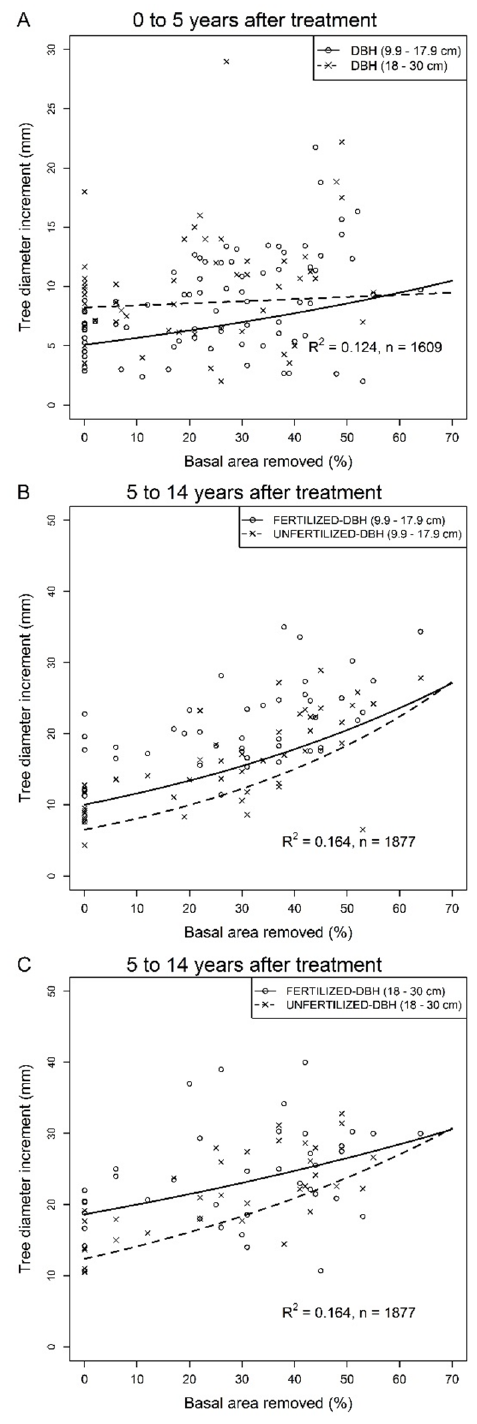
Figure 2. Residual tree response to commercial thinning and fertilization of jack pine stands over periods of 5 and 5 to 14 years following thinning. Fertilization was conducted within sub-plots in each experimental units 3 to 5 years after thinning; ( A ) Tree diameter increment (mm) over the first 5 years after commercial thinning in unfertilized plots as a function of basal area removed and tree size; ( B ) Diameter increment (mm) of small diameter trees over the 5- to 14-years period following commercial thinning as a function of basal area removed and fertilization; ( C ) Diameter increment (mm) of large diameter trees over the 5- to 14-years period following commercial thinning as a function of basal area removed and